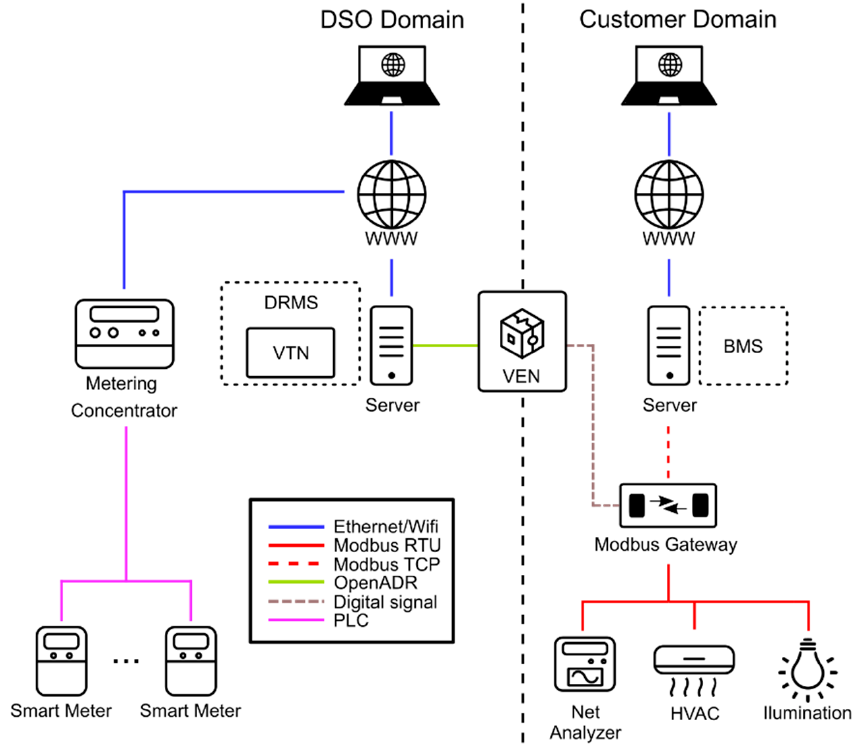
Figure 6. DERBis systems overview. DRMS: Demand Response Management System; VTN: Virtual Top Node; VEN: Virtual End Node; BMS: Building Management System.